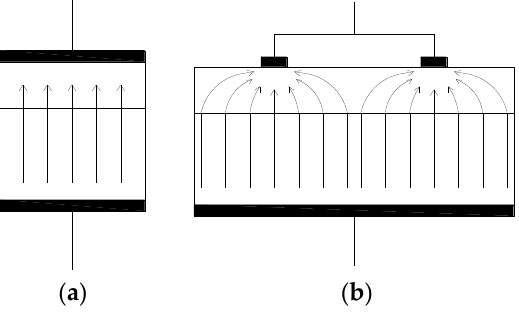
Figure 1. Schematic electrical charges flow paths ( a ) in a diode and ( b ) in a photovoltaic (PV) cell.